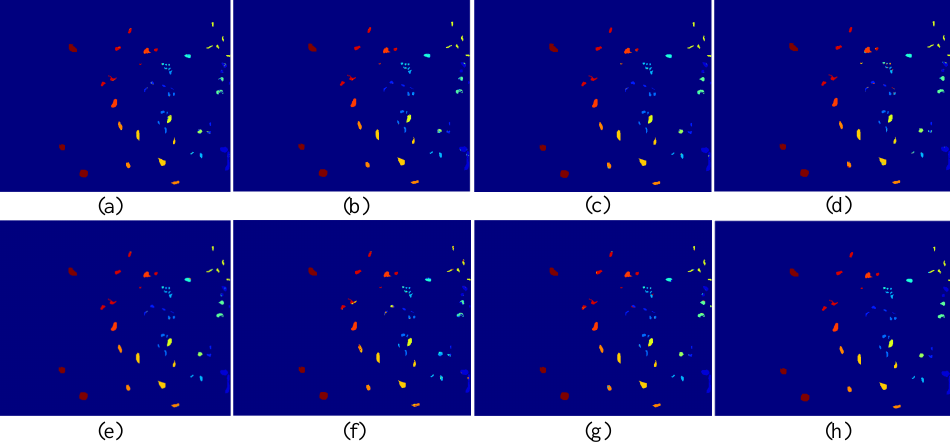
Figure 10. Classification maps using eight different methods on the KSC dataset: ( a ) original; ( b ) RLDE; ( c ) MDA; ( d ) 2D-CNN; ( e ) 3D-CNN; ( f ) LSTM; ( g ) CNN+LSTM; ( h ) Bi-CLSTM.